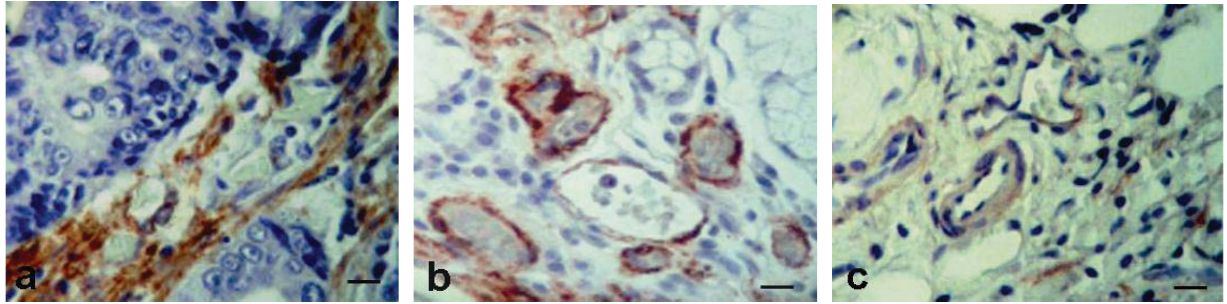
Figure 3. Immunohistochemical staining of (cid:2) -SMA in periendothelial cells